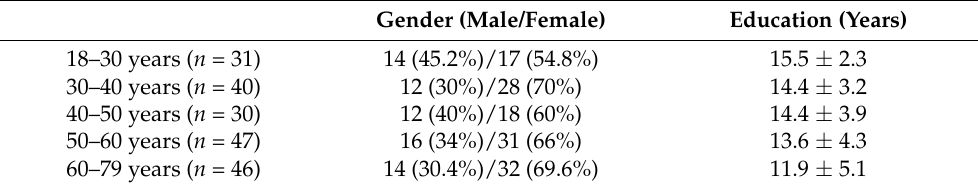
Table 1. Distribution of healthy volunteers according to age